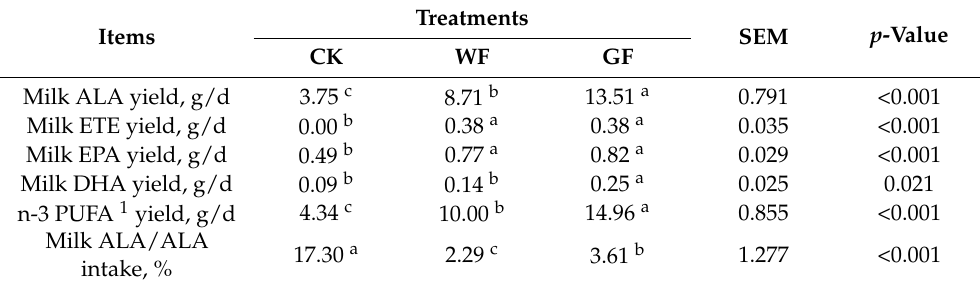
Table 5. Milk ALA, EPA, DHA, and total n-3 PUFA yield of different treatment groups.